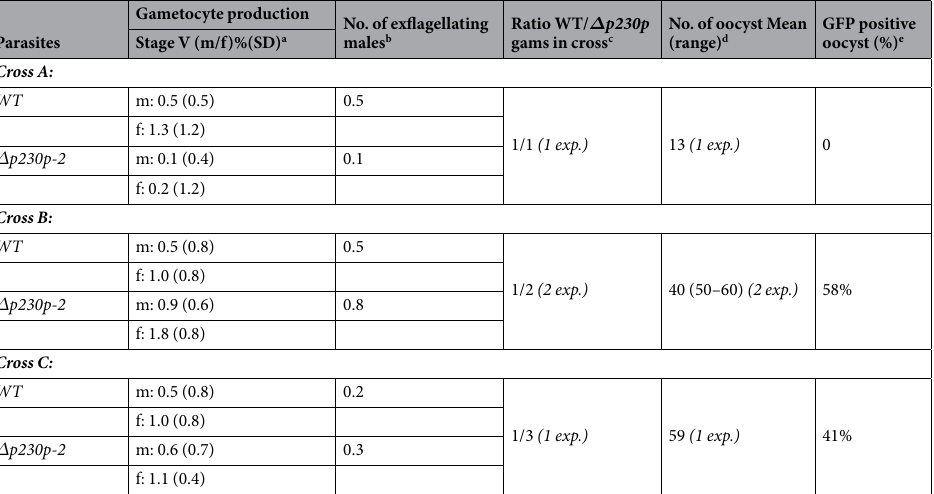
Table 2. GFP-positive and GFP-negative oocysts after crossing P . falciparum WT and pf Δ p230p gametocytes. a Mean percentage of stage V male (m) and female (f) gametocytes (per 100 red blood cells) in day 14 cultures in 1–2 experiments (exp.). SD: Standard deviation. b Mean number of exflagellating male gametocytes (per mL of culture) at 10–20 min after activation of day 14 gametocyte cultures (SD: standard deviation). c WT and Pf Δ p230p gametocytes were mixed in different ratios (1:1, 1:2, and 1:3) based on exflagellating male gametocytes counts per ml of gametocyte culture after activation with FCS. d Mean number of oocysts per mosquito at day 8 after feeding. Range corresponds to the mean number of oocyst in different experiments (1–2 exp. per crossing; 10–30 mosquitoes per exp.). e Percentage of GFP positive oocyst analysed in 5 individuals mosquitoes (1–2